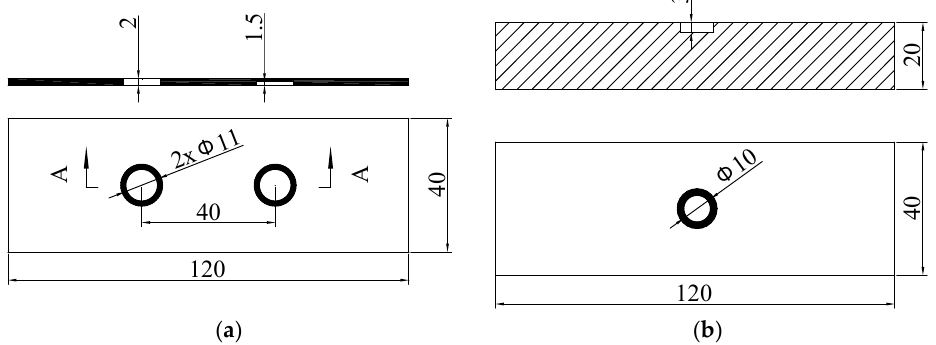
Figure 16. ( a ) Glass-fibre composite board (Specimen I) and ( b ) Aluminium specimens (Specimen II).